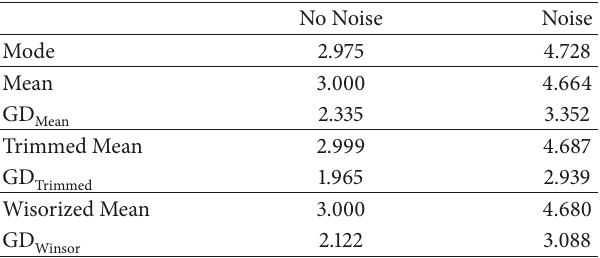
Table 1: Measures of location for the data of Figure 1. The ideal value to be obtained is 3. The acronym GD indicates the values obtained with the use of the Geodesic on the Gaussian Manifold (GDGM) proposedinthepaper,whichreducestheerrorsintheestimateseven of an order of magnitude recovering almost the right value of